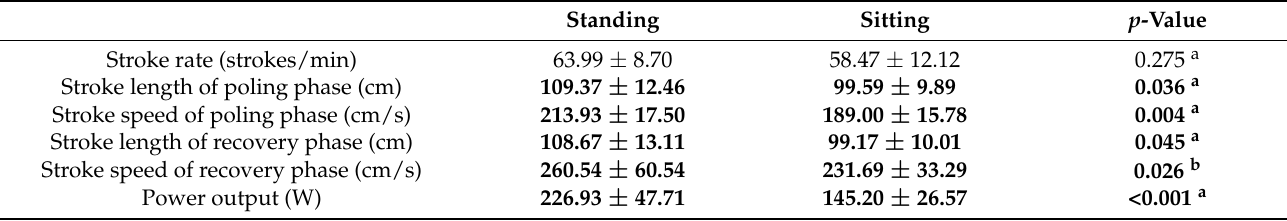
Table 1. The variables of double poling performance in each position. Standing Sitting p